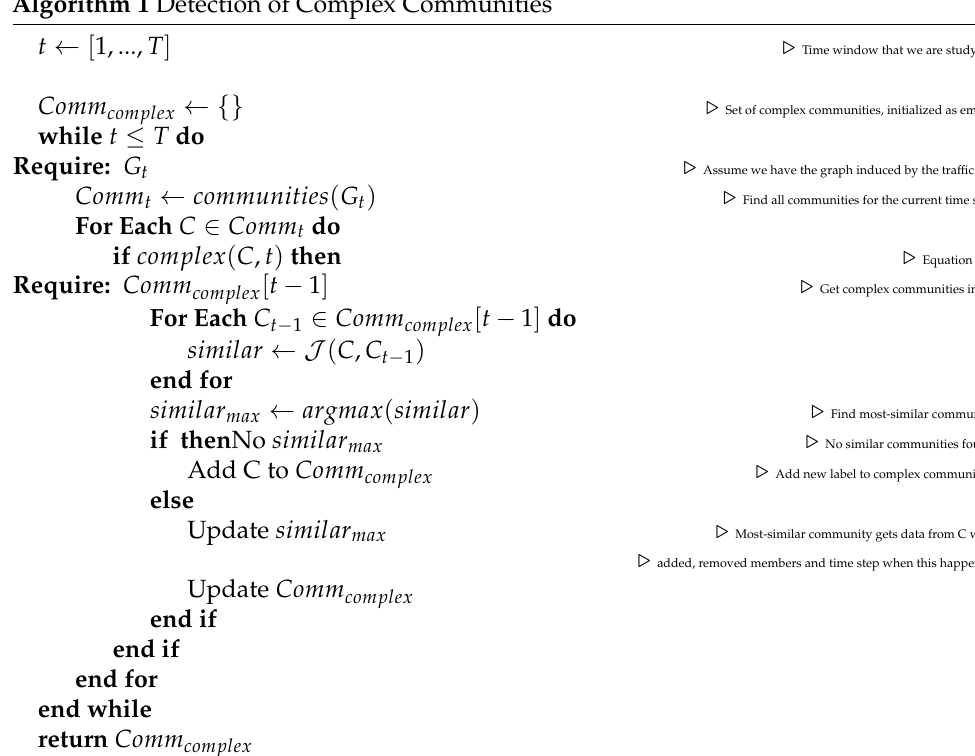
Algorithm 1 Detection of Complex